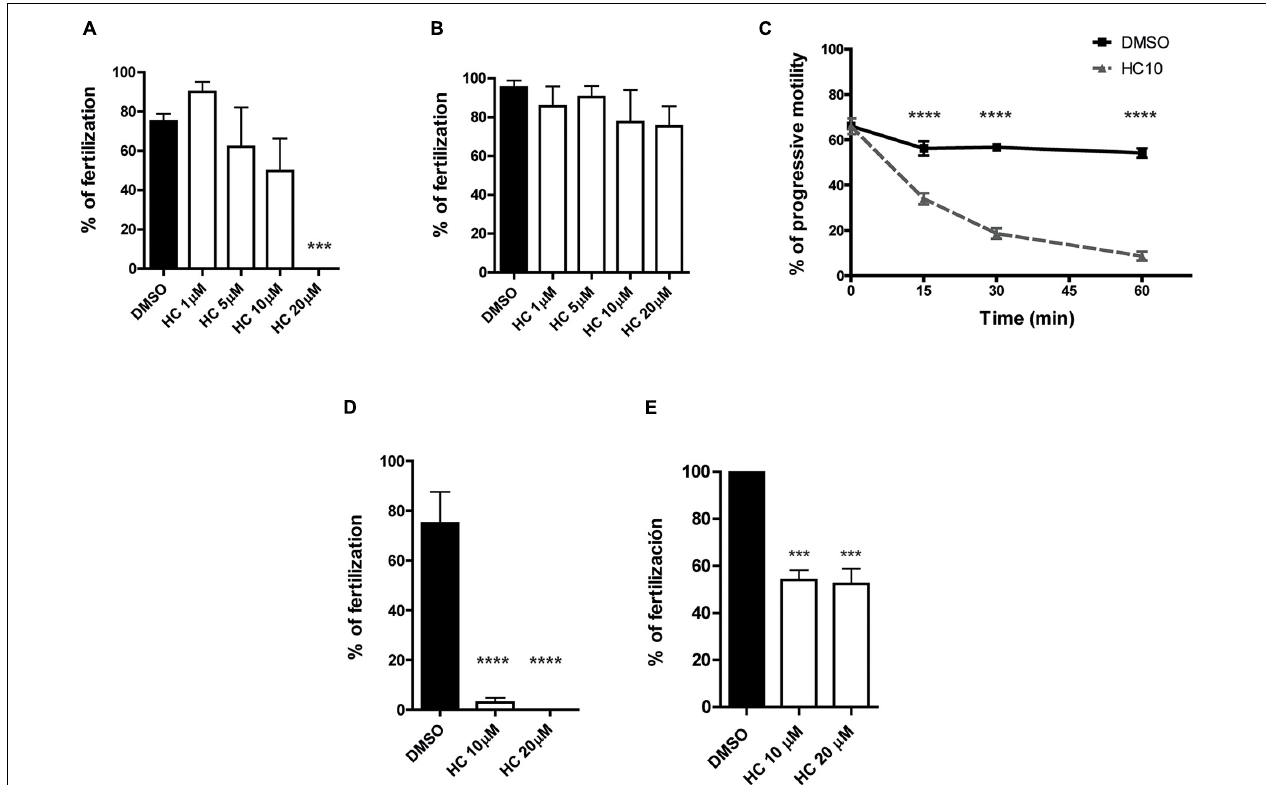
FIGURE 3 | In vitro fertilizing ability of sperm exposed to HC after capacitation. (A,B) Cauda epididymal sperm incubated under capacitating conditions for 90 min in medium alone were coincubated with either COC for 3 h (A) or ZP-free oocytes for 1 h (B) , in media containing different concentrations of HC (1, 5, 10, and 20 µ M) or DMSO as control. At the end of incubations, fertilization was evaluated. Eggs were considered fertilized when at least one decondensing sperm nucleus or two pronuclei were observed in the egg cytoplasm and the percentage of fertilized eggs was determined. (C) Percentage of sperm progressive motility as a function of coincubation time in the presence of 10 µ M HC. Samples collected at different capacitation times were analyzed by light microscopy ( × 400). (D,E) Sperm incubated under capacitating conditions for 90 min in medium alone were then incubated with HC (10 and 20 µ M) for 30 min prior to their coincubation with either COC for 3 h (D) or ZP-free oocytes for 1 h (E) , in media containing different concentrations of HC (10 and 20 µ M) or DMSO as control. At the end of incubations, fertilization was evaluated as described above. Data are mean ± SEM of at least n = 3 independent experiments; *** p < 0.0005; **** p < 0.0001 vs. DMSO.